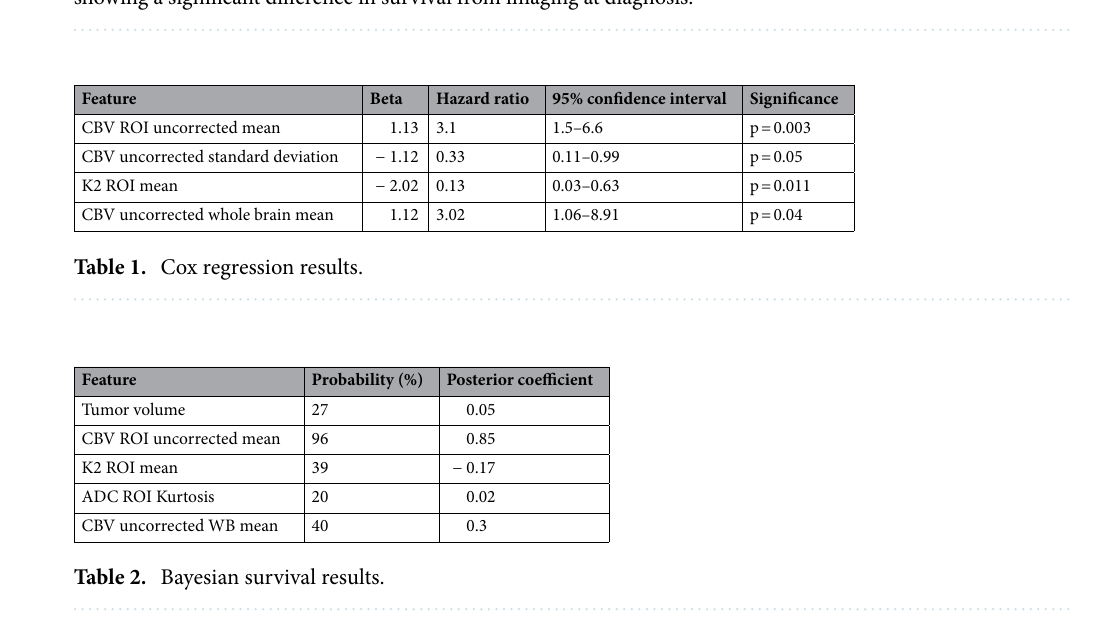
Figure 3. ( A ) Overall survival curve for the cohort, ( B ) K Means clustering survival results showing two distinct clusters, ( C ) Kaplan–Meier curve for the two clusters showing a significant difference in survival, 1 = High risk, 2 = Low risk, ( D ) Kaplan–Meier curves for high-grade low-risk (green) and high-risk (red) patients showing a significant difference in survival from imaging at diagnosis.